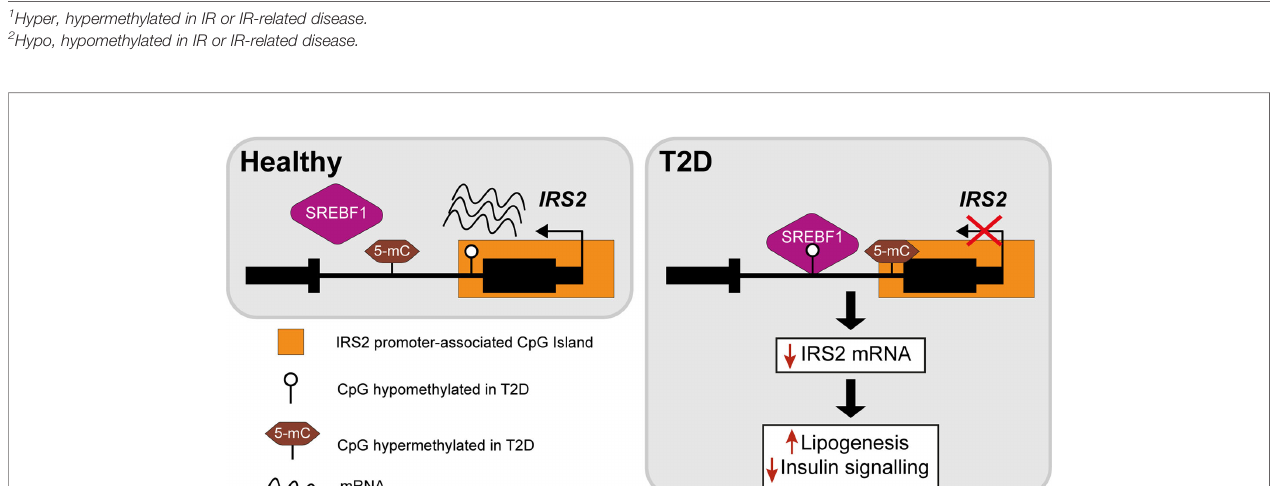
FIGURE 3 | Epigenetic dysregulation of the IRS2 locus in the livers of T2D patients. Comparison of obese T2D and non-T2D revealed that the IRS2 locus, which encodes a core mediator of insulin signalling in the liver, is differentially methylated in the livers of T2D patients (41). Observed changes include the hypermethylation of a CpG site near the promoter of IRS2 and hypomethylation of an intronic SREBF1 binding site. SREBF1 has been previously shown to interfere with the binding of transactivators to IRS2 (42). Ultimately, these changes lead to the decreased expression of IRS2 in hepatocytes, effectively reducing insulin signalling and enhancing